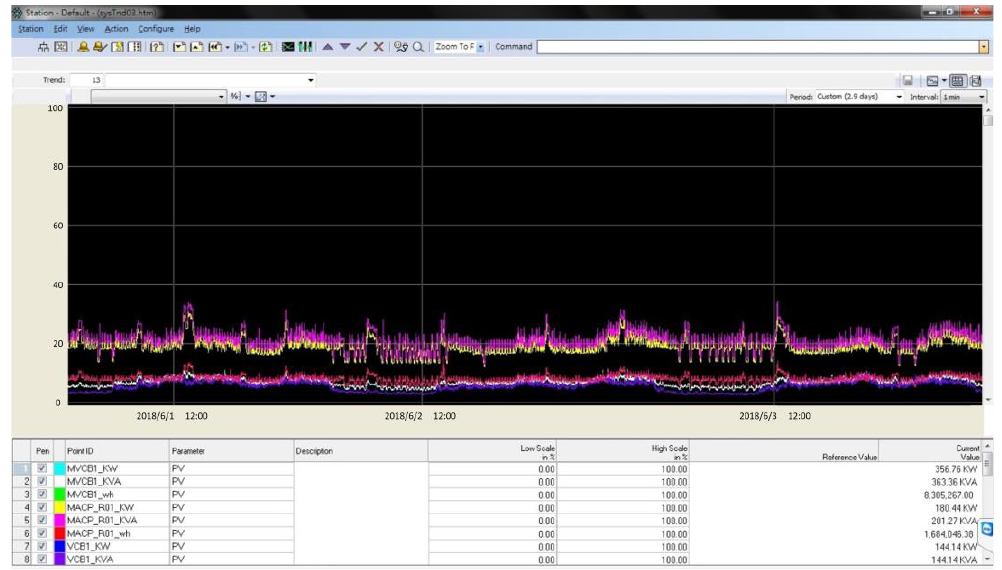
Figure 3. Data collection by the building management system.